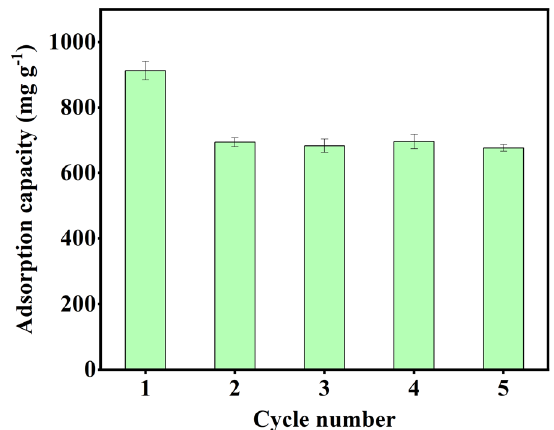
Fig. 9 Adsorption capacity of OSSC-2-700 toward MG at different cycle